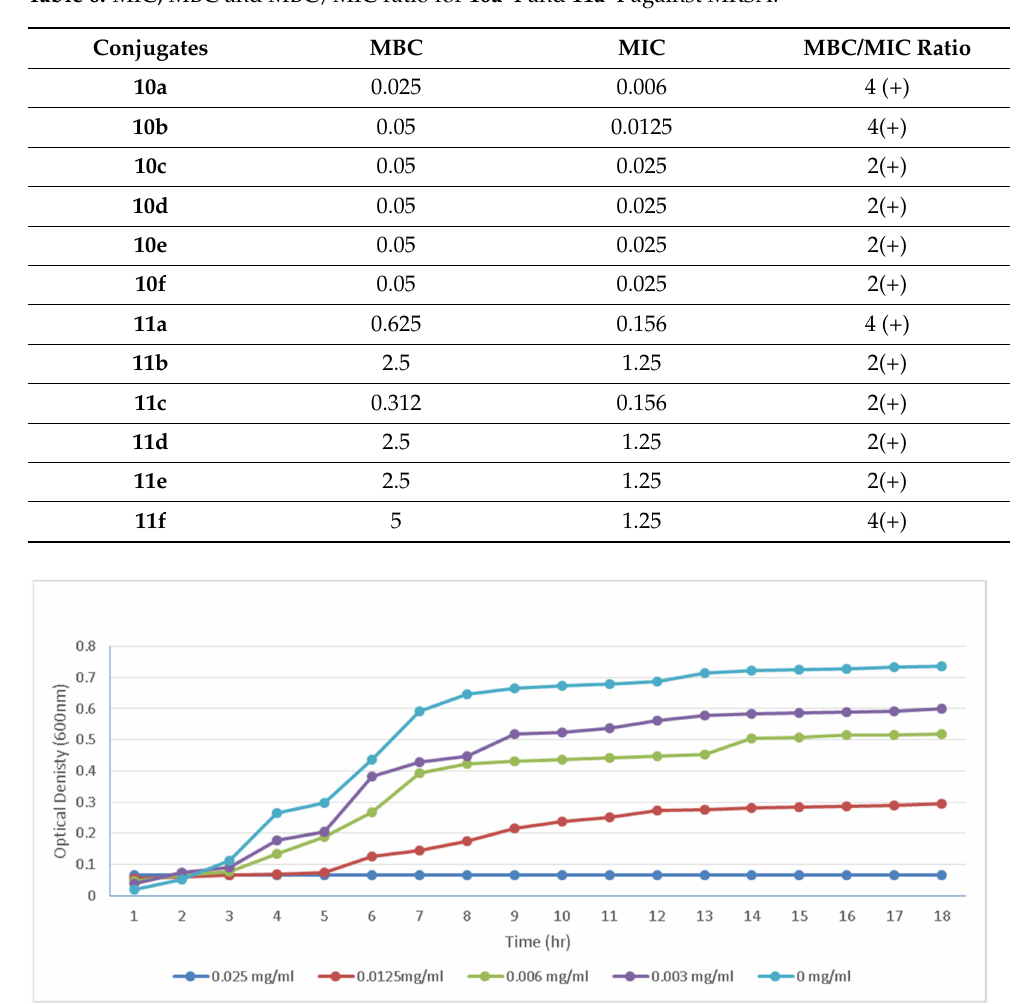
Figure 2. Time-kill plot for MRSA in the presence of 10a